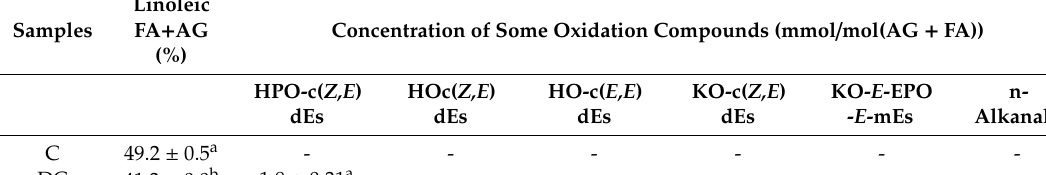
Table 2. Molar percentage of linoleic fatty acids (FA) plus acyl groups (AG) (FA + AG), in relation to the total moles of all kinds of AG and FA, in the corn oil C, in the digestates of this oil DC, and in those of the oil samples enriched in gamma - and alpha -tocopherol (DC0.2 γ T, DC2 γ T, DC5 γ T, DC0.2 α T, DC2 α T and DC5 α T). Concentration of some oxidation compounds, expressed by mmol per mol of AG + FA in the above samples. Di ff erent letters within each column indicate statistically significant di ff erence among the samples ( p <